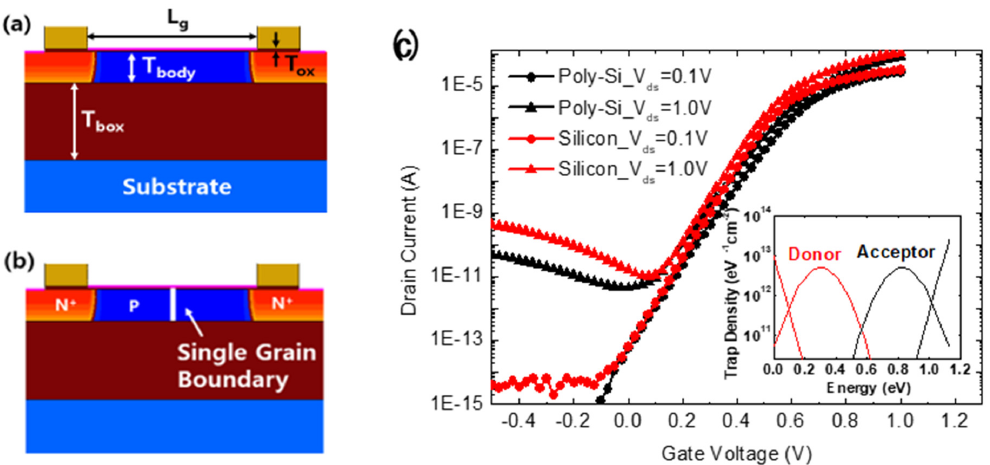
Figure 1. Cross-section of the simulated structure of ( a ) silicon one-transistor dynamic random-access Figure 1. Cross ‐ section of the simulated structure of ( a ) silicon one ‐ transistor dynamic random ‐ access memory (1T-DRAM); and ( b ) poly-Si 1T-DRAM; ( c ) transfer characteristics of silicon 1T-DRAM and memory (1T ‐ DRAM); and ( b ) poly ‐ Si 1T ‐ DRAM; ( c ) transfer characteristics of silicon 1T ‐ DRAM and poly-Si 1T-DRAM devices (inset, density of states used for poly-Si